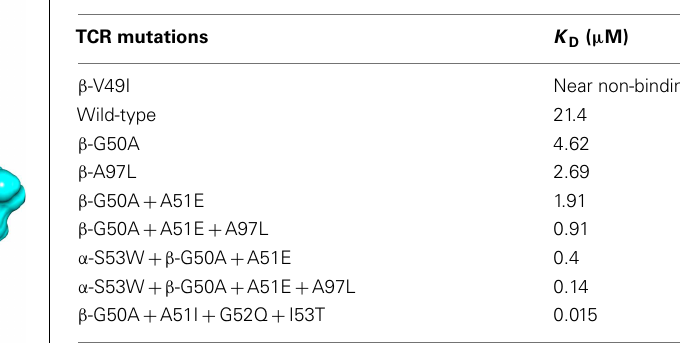
Table 1 | Binding affinity of rationally designed BC1TCR variants [from Ref. (7)] measured by SPR.